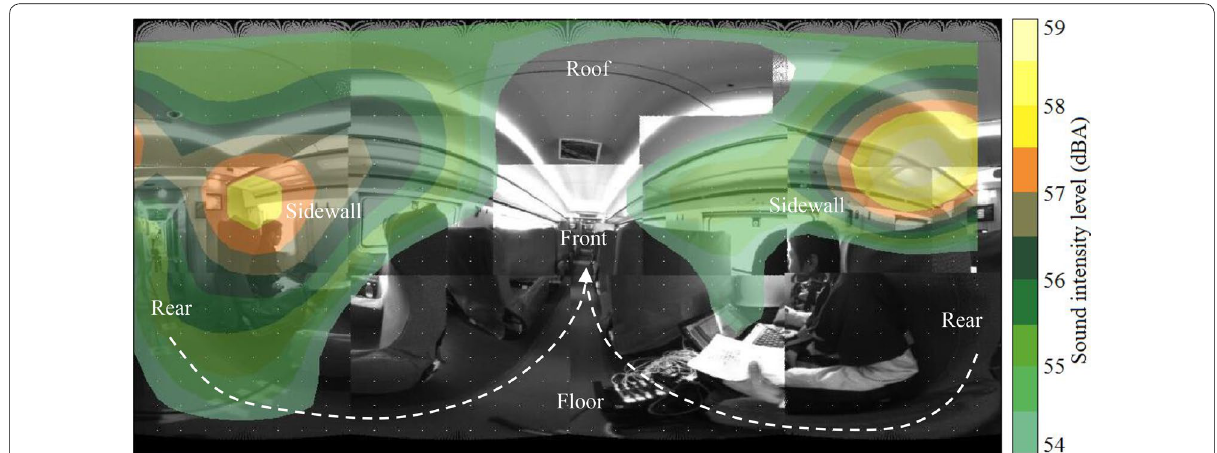
Figure 7 Interior noise source distribution at the end of the first coach running at 310 km/h (frequency range: 500–5000